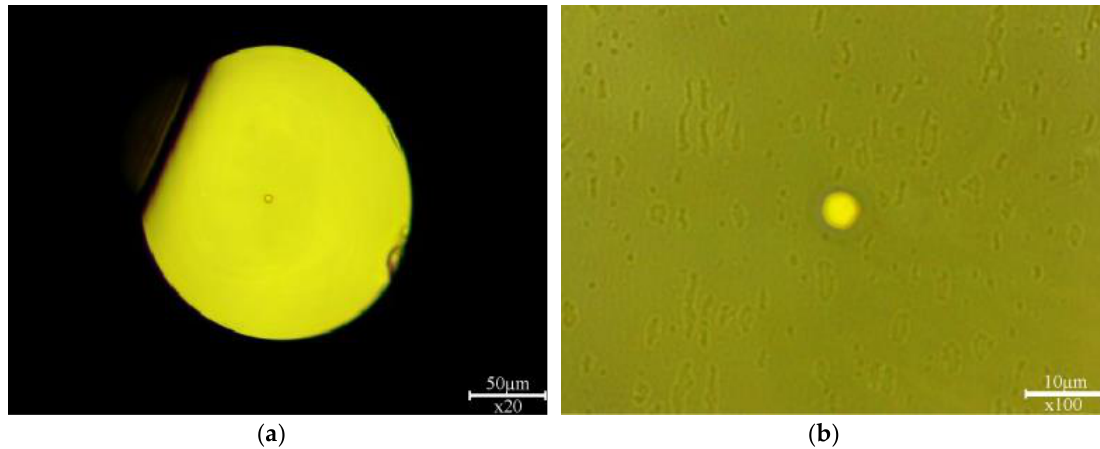
Figure 3. Cross-section of the small core step-index fibre under optical binocular with ( a ) a × 20 objective and ( b ) a × 100 objective.